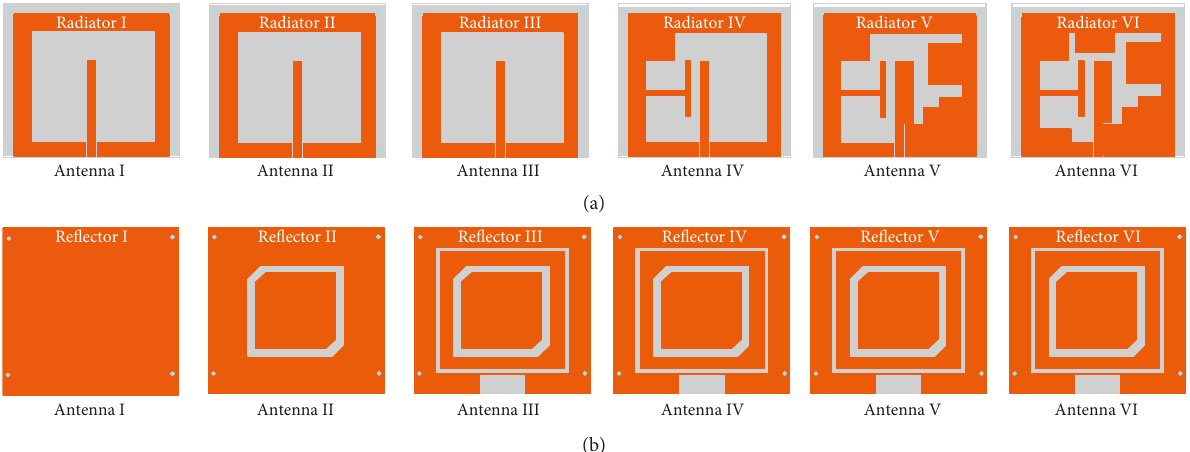
Figure 2: Evolution and the design steps of the proposed antenna, from Antennas I to VI. (a) The radiator on the upper layer and (b) the reflector on the lower layer.